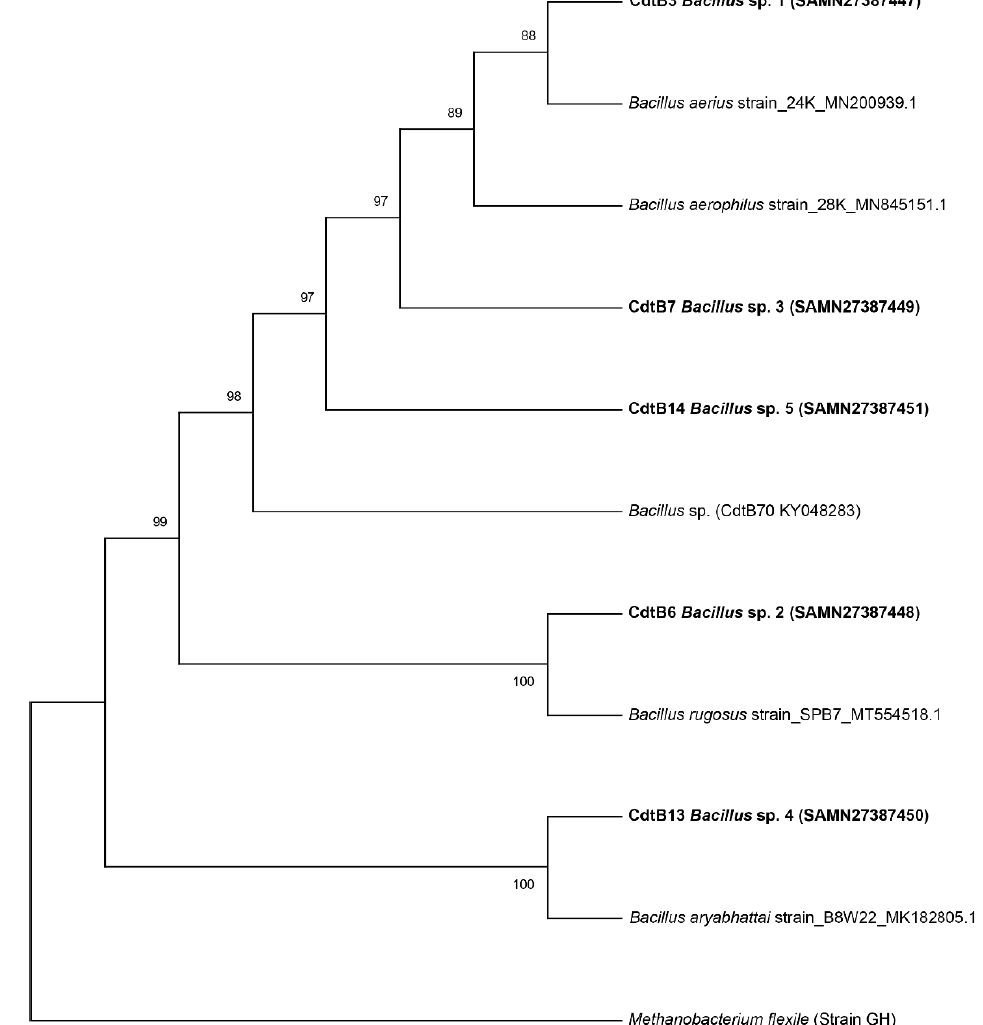
Figure 1. Phylogenetic relationship of cadmium-tolerant bacteria (CdtB) isolated in this study from cacao farms in Antioquia district. The strains were compared with reference sequences of CdtB isolated from other areas. The strains written in bold correspond to the CdtB isolated in this study.